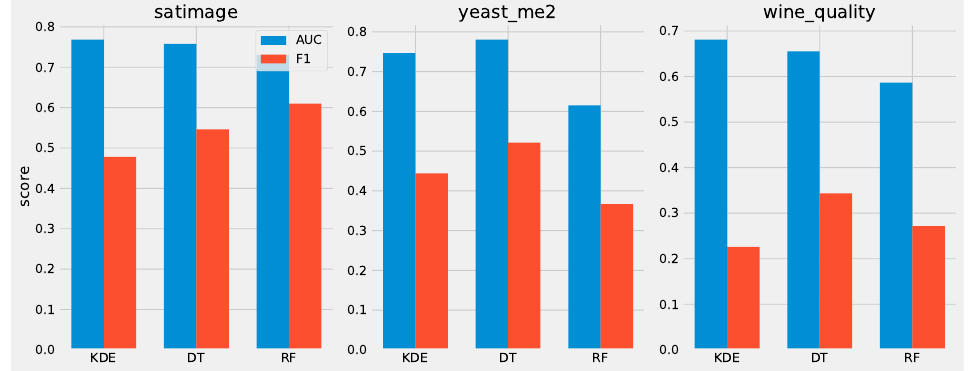
Figure 7. Classifier performances as measured by AUC and the F 1